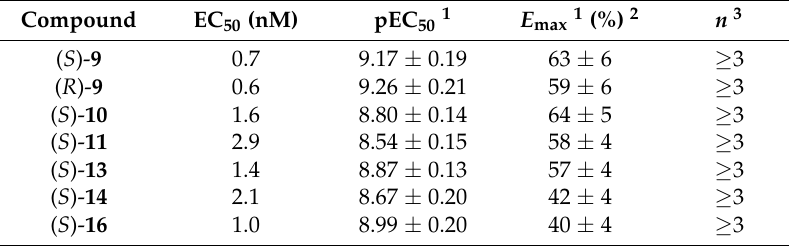
Table 2. Inositol phosphate accumulation assay to determine agonistic potencies of candidate molecules.